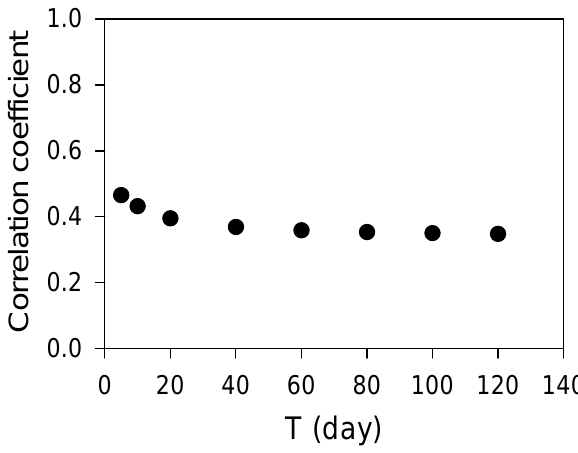
Fig. 8. Relationship between T and correlation coefficient ( p < 0.0001) (derived from the relationship between stream water DOC concentration and API for the corresponding T value).